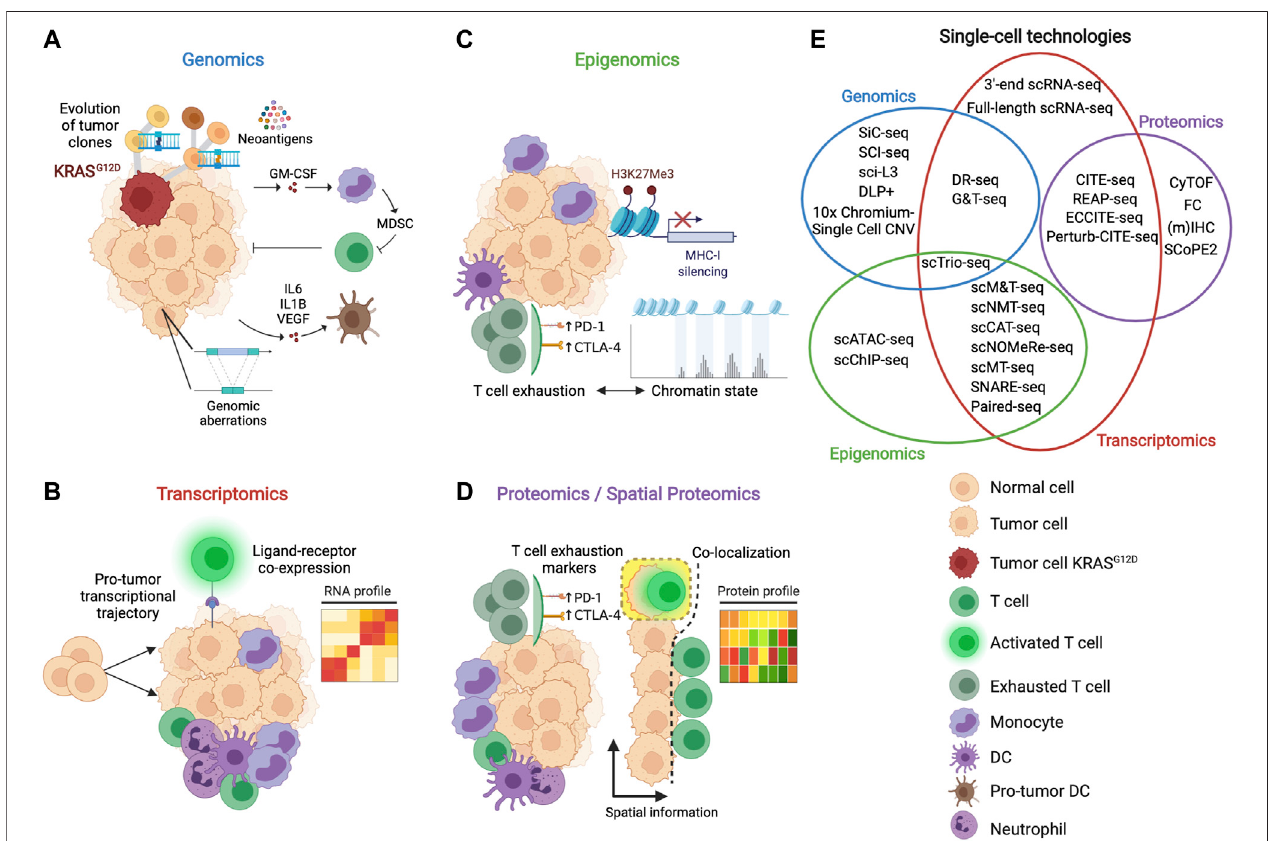
FIGURE1| Multi-omicperspectivetostudythefeaturesoftheTME. (A) Genomicsanalysisinformsabouthowthetumormutationallandscapein fl uencestheTME, favoring,forexample,theproductionofcytokines(e.g.,IL-6,IL1- β )andgrowthfactors(e.g.,GM-CSF)inducingtheproliferationofsuppressivemyeloidcellsandthepro- tumor differentiation of antigen-presenting cells. (B) Transcriptomic analysis enables to inspect the transcriptional machinery of the single cells of the TME, deciphering, for example, developmental trajectories, cell states and cell-cell interactions. (C) Epigenomic analysis reveals how speci fi c switches such as histone methylation and chromatin dynamics regulate different mechanisms capable to interfere with anti-tumor immune recognition and effector functions. (D) Proteomics provides informationabout thestate ofactivation ofthe immune cellsoftheTMElooking at theexpression ofimmunomodulatoryproteins such ascheckpoint inhibitors(e.g.,PD- L1, CTLA-4). Spatial proteomics gives additional information about the localization of the cells allowing, for example, to identify cell that interact in the TME. (E) Venn diagram depicting single-cell technologies to study single (non-overlapping sets) or multimodal (overlapping sets) omics. Genomics, transcriptomics, epigenomics and proteomics are represented as blue, red, green, and purple sets,